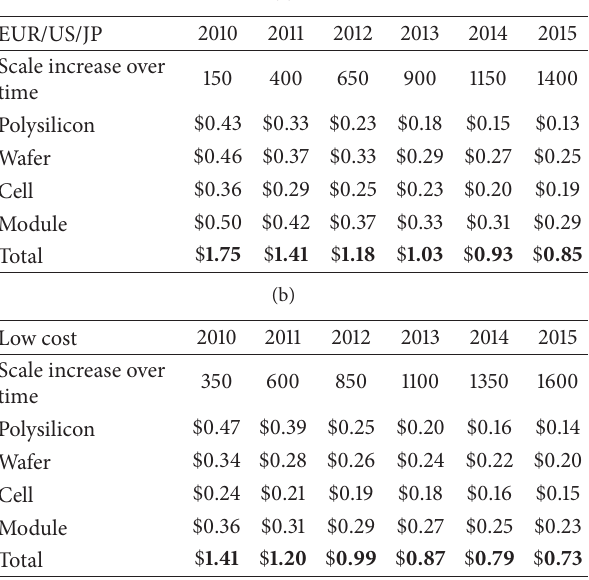
Table 2: Crystalline Si: estimated total module cost